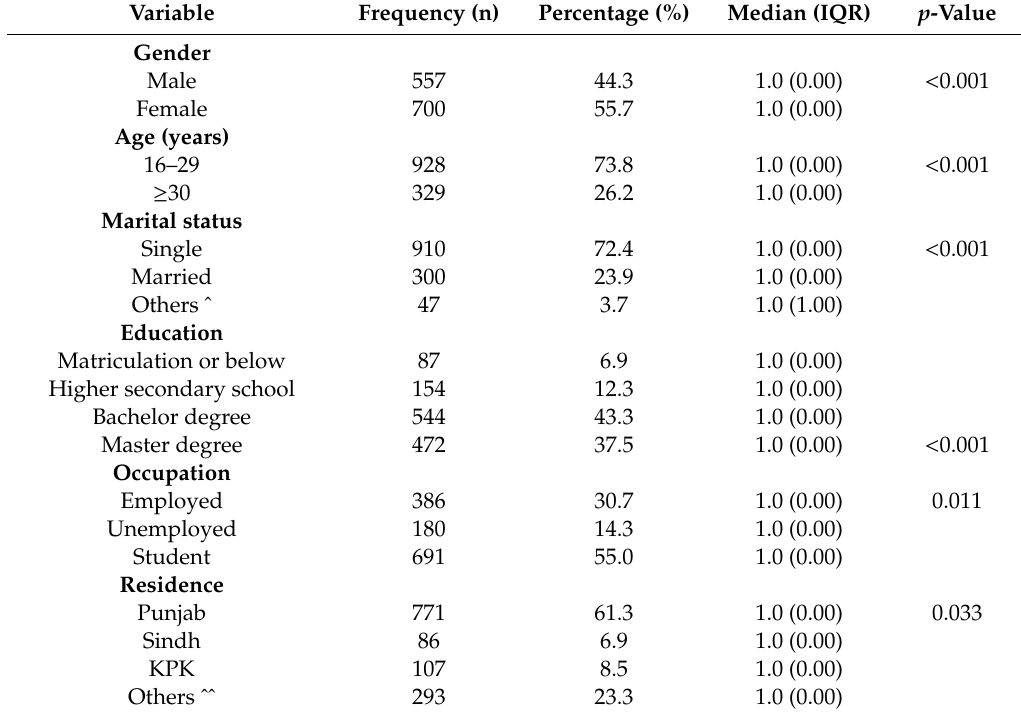
Table 2. Demographic characteristics of the participants and the knowledge score ( n =